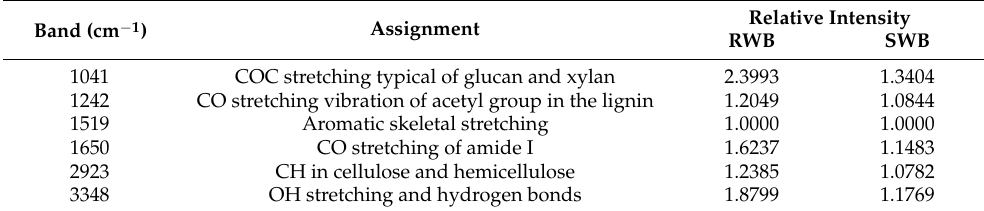
Figure 1. FTIR spectroscopy of raw wheat bran (RWB) and steam-exploded wheat bran (SWB). Table 1. FTIR semi-quantitative analysis of RWB and SWB.